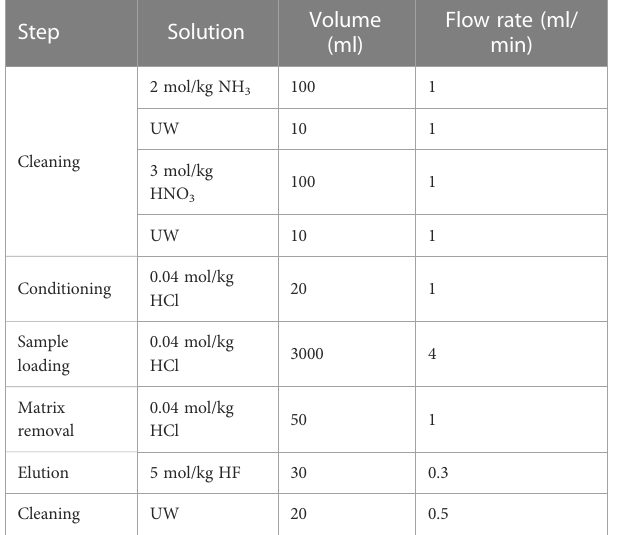
TABLE 2 Procedure of anion exchange chromatography with